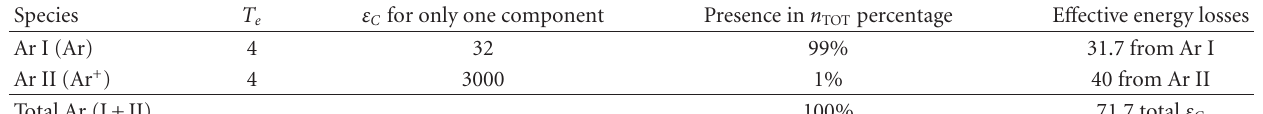
Table 6: Approximate collisional energy losses in the mantle plasma region.